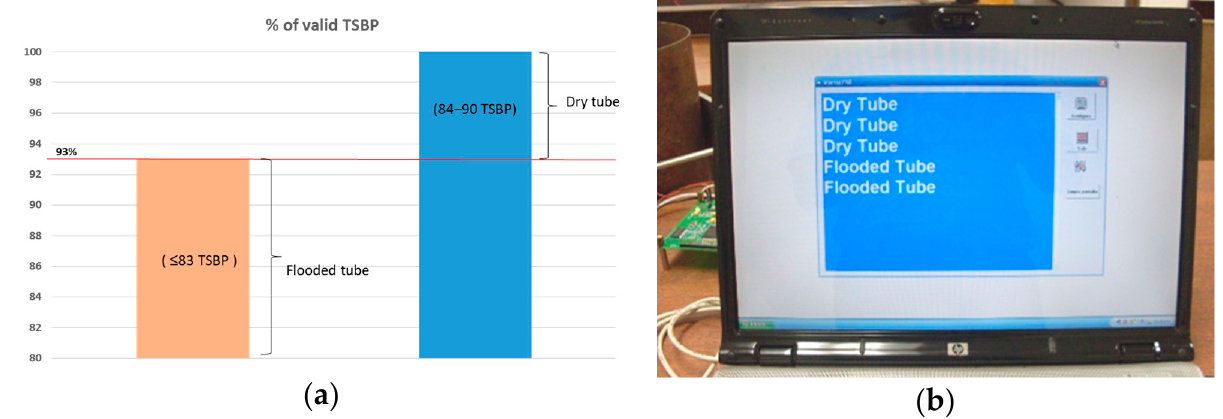
Figure 13. ( a ) Normalized FMD threshold in percentage for the calculated number of TSBP; ( b ) displayed results in a human–machine interface in ASCII standard.